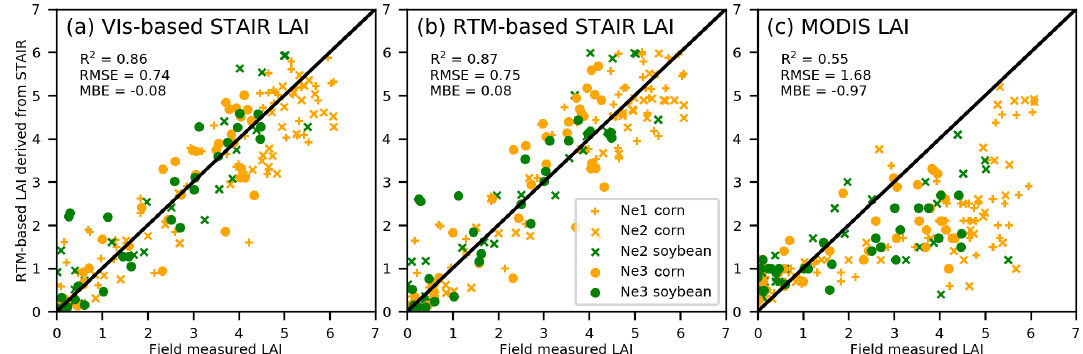
Figure 3. Scatter plots between LAI measurements and LAI estimations. LAI measurements are destructively collected at the three Mead sites. (a–b) STAIR-derived daily 30m resolution LAI using the VI-based method and the RTM-based method, respectively. (c) 500m resolution MODIS LAI.